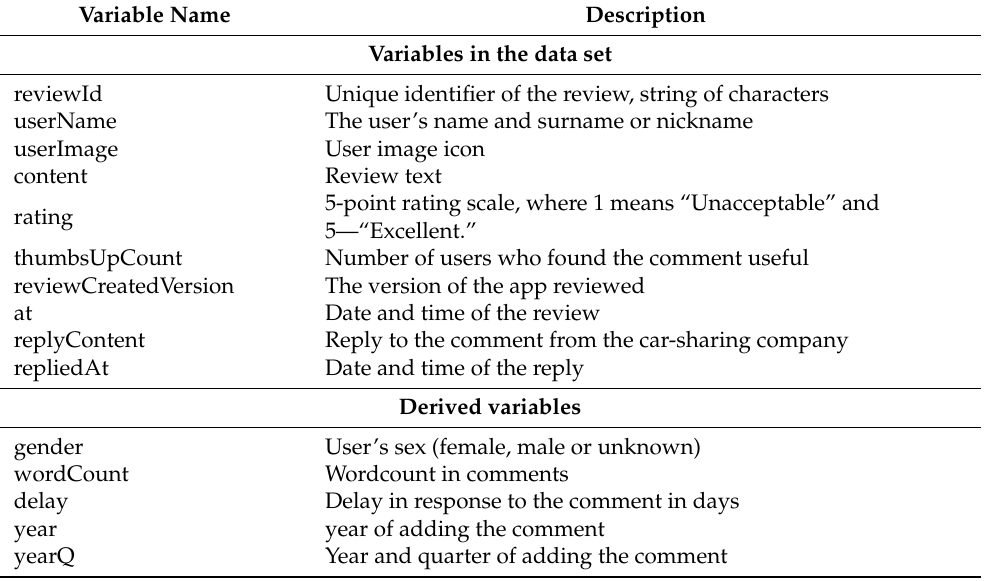
Table 3. Variable in the data set and derived variables.